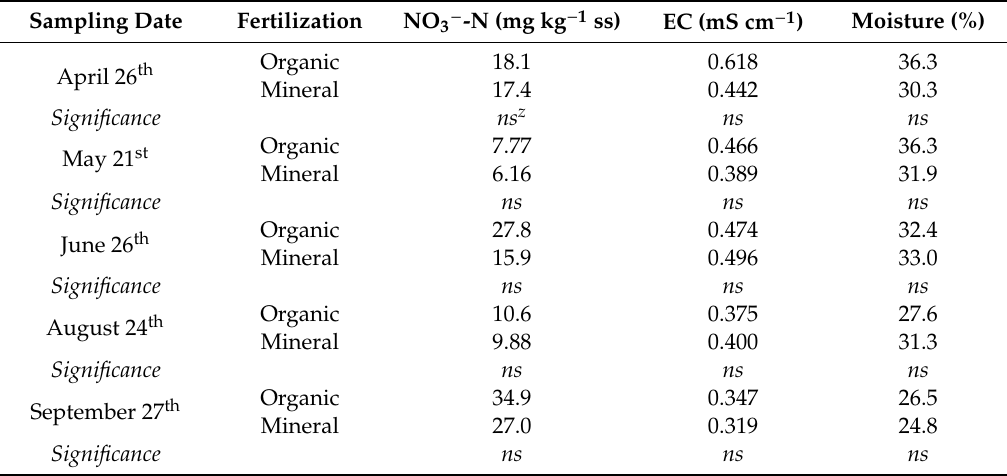
Table 3. Soil nitrate (NO 3 − -N) concentration, electric conductivity (EC) and moisture during the experiment (values are average of data from all